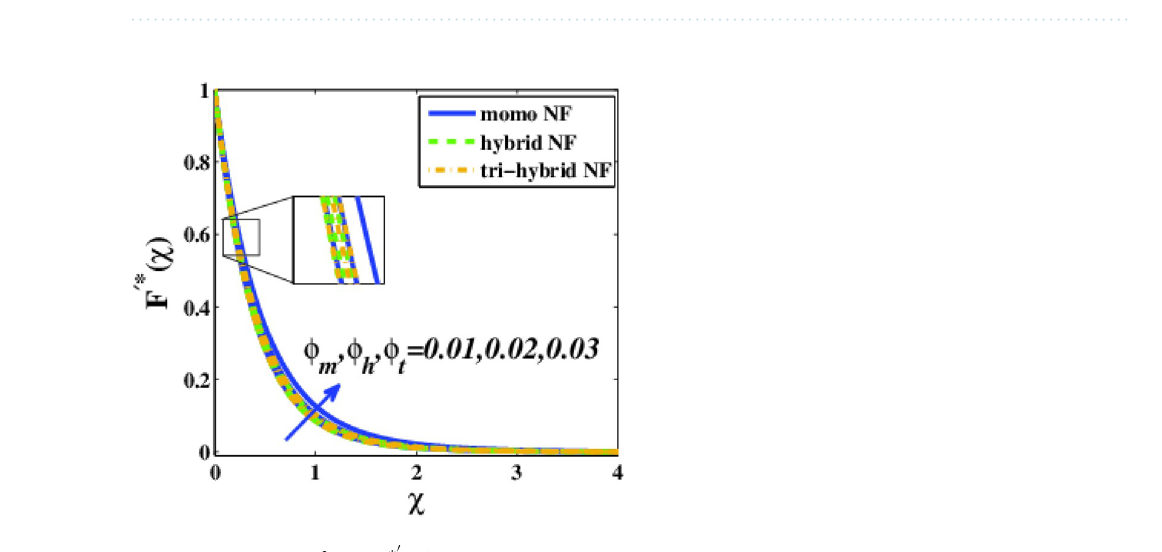
Figure 18. Impact of φ on F ∗ ′ (χ) .